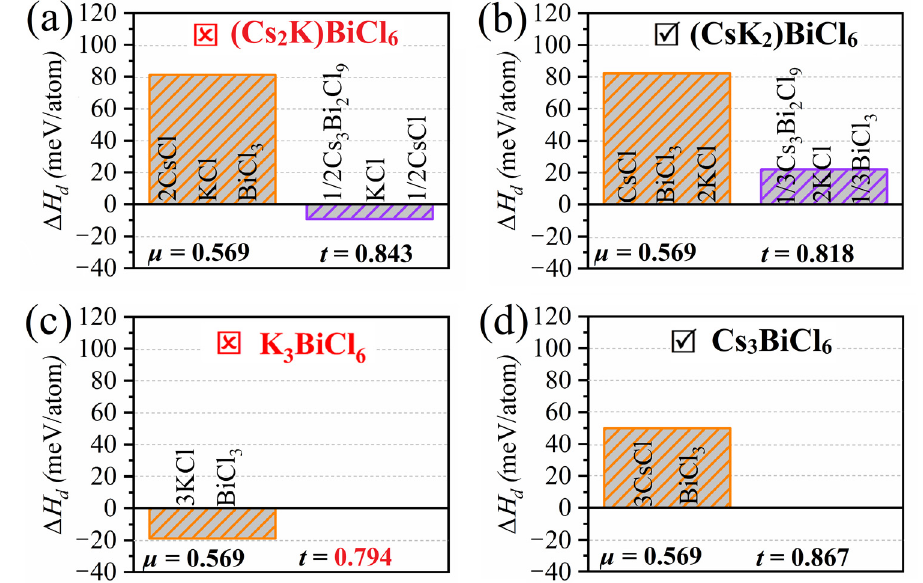
Figure 2. Calculated decomposition enthalpies ( Δ H d ) of (Cs 2 K)BiCl 6 ( a ), (CsK 2 )BiCl 6 ( b ), K 3 BiCl 6 ( c ) and Cs 3 BiCl 6 ( d ). The orange bars indicate pathways involving only binary compounds. The violet bars indicate the lowest Δ H d pathways involving ternary compounds. K 3 BiCl 6 and Cs 3 BiCl 6 do not involve decomposition paths for ternary compounds. The Goldschmidt tolerance factor (t) and the octahedral factor ( μ ) are also indicated, red indicates unsuitable values.